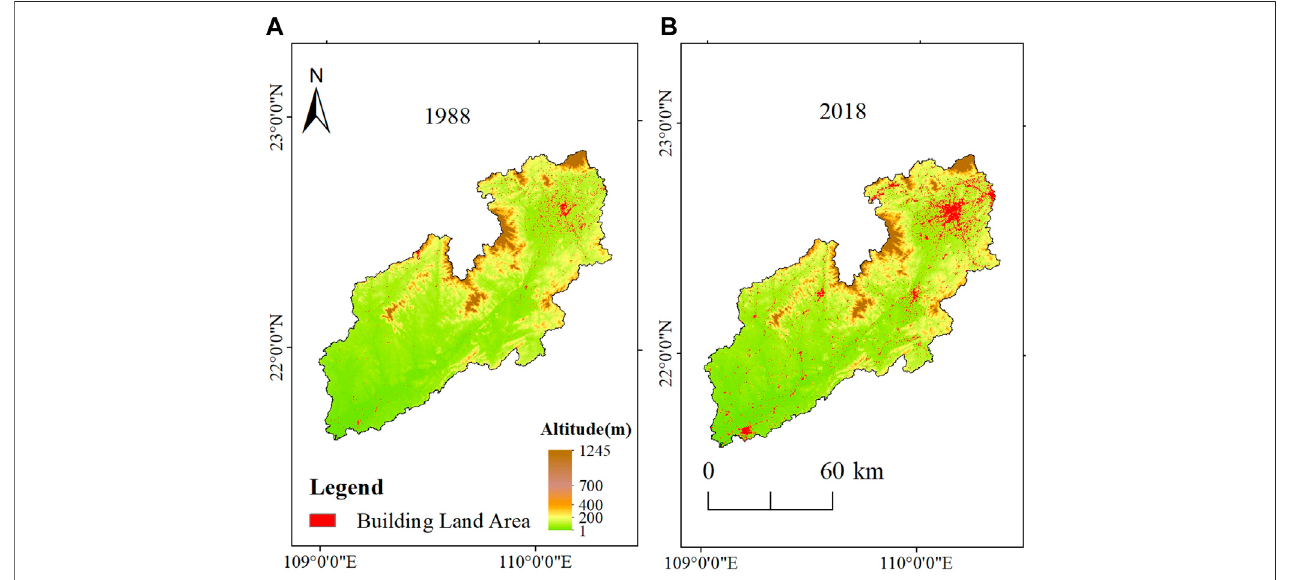
FIGURE 14 | Changes in nanliu river building land area: (A) 1988; (B) 2018.